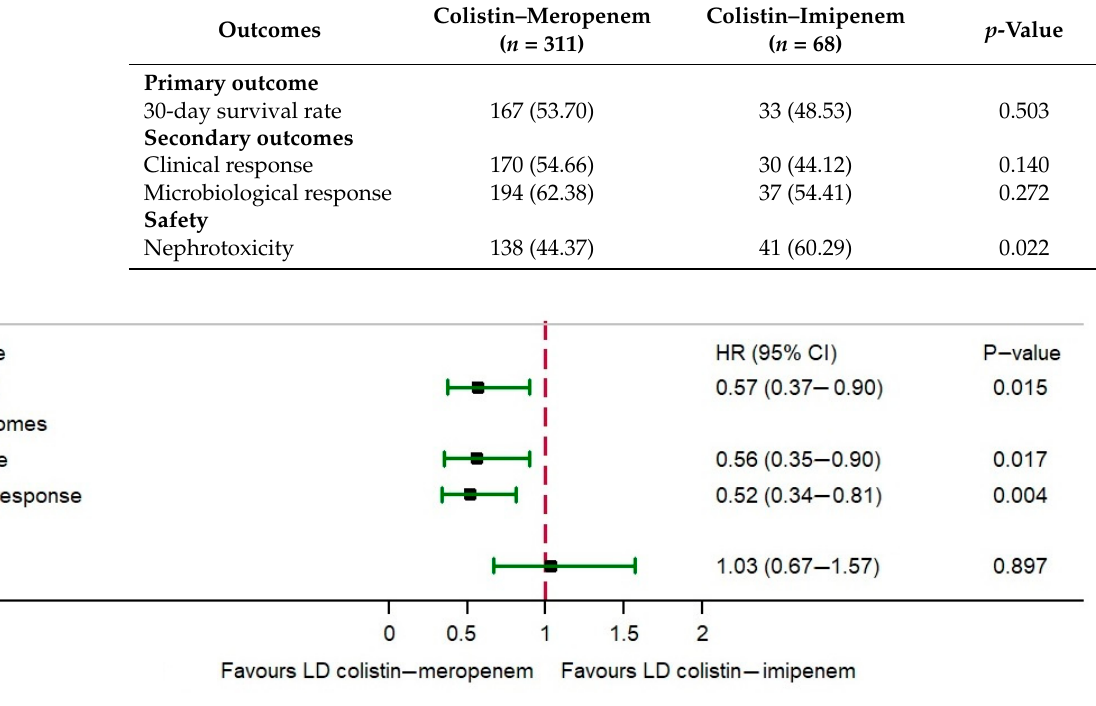
Figure 1. Forest plot of hazard ratios and 95% confidence intervals of outcomes for patients with CRAB infection receiving LD colistin–meropenem and LD colistin–imipenem therapy. Table 3. Cox regression analysis of safety for CRAB infection between LD colistin–meropenem compared to LD colistin–imipenem therapy.